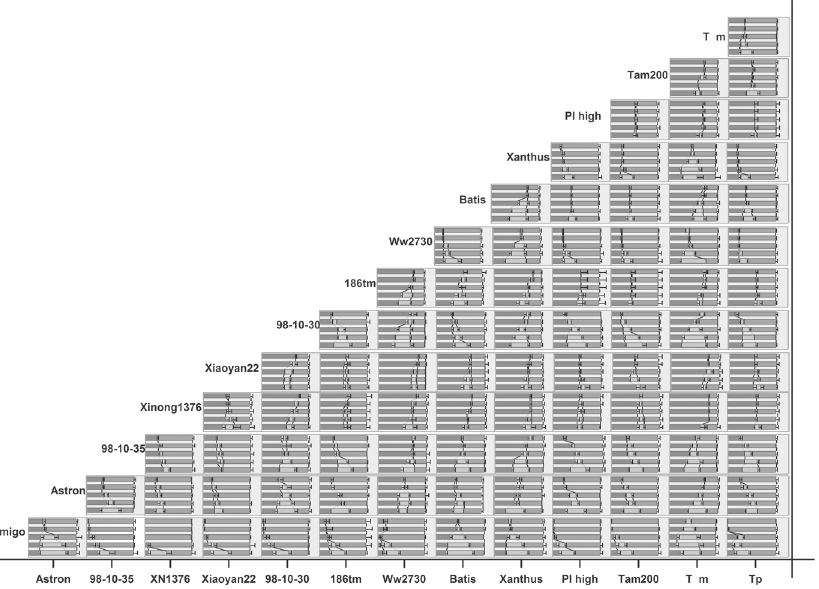
Fig 1. S . avenae alatae selection dynamics between 2 wheat varieties/lines. This figure includes 91 graphs (14 wheat varieties/lines) representing the random combination of 91 pairs. Each paired combination includes 2 different wheat varieties/lines. Each graph shows how 20 alatae selected between the 2 wheat varieties/lines (for each small graph of the paired combinations, the name of the variety on the left is on the horizontal axis, while the name of the variety on the right is above each graph) at 1 h, 2 h, 4 h, 8 h, and 24h (from the bottom